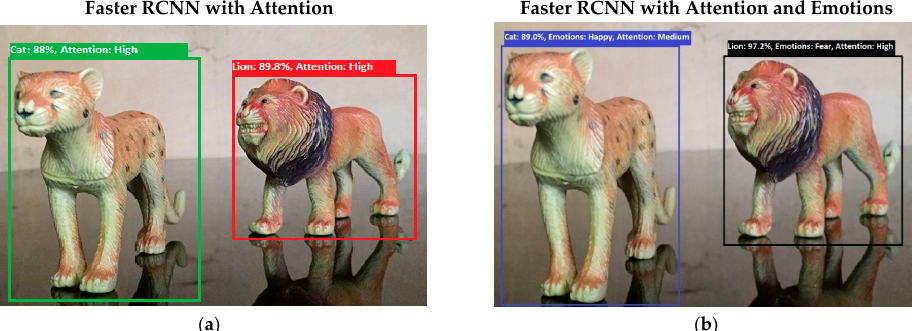
Figure 6. ( a ) This figure shows the bottom-up (feature-based) attention-based recognition of an object such as a cat with 89% accuracy, and the attention level is high. ( b ) This figure shows the bottom-up (feature-based) attention-based recognition of an object such as a cat, and the emotion of the system converts to a happy state from the previous fear emotion. Happy is an intense emotional state, so attention is high.